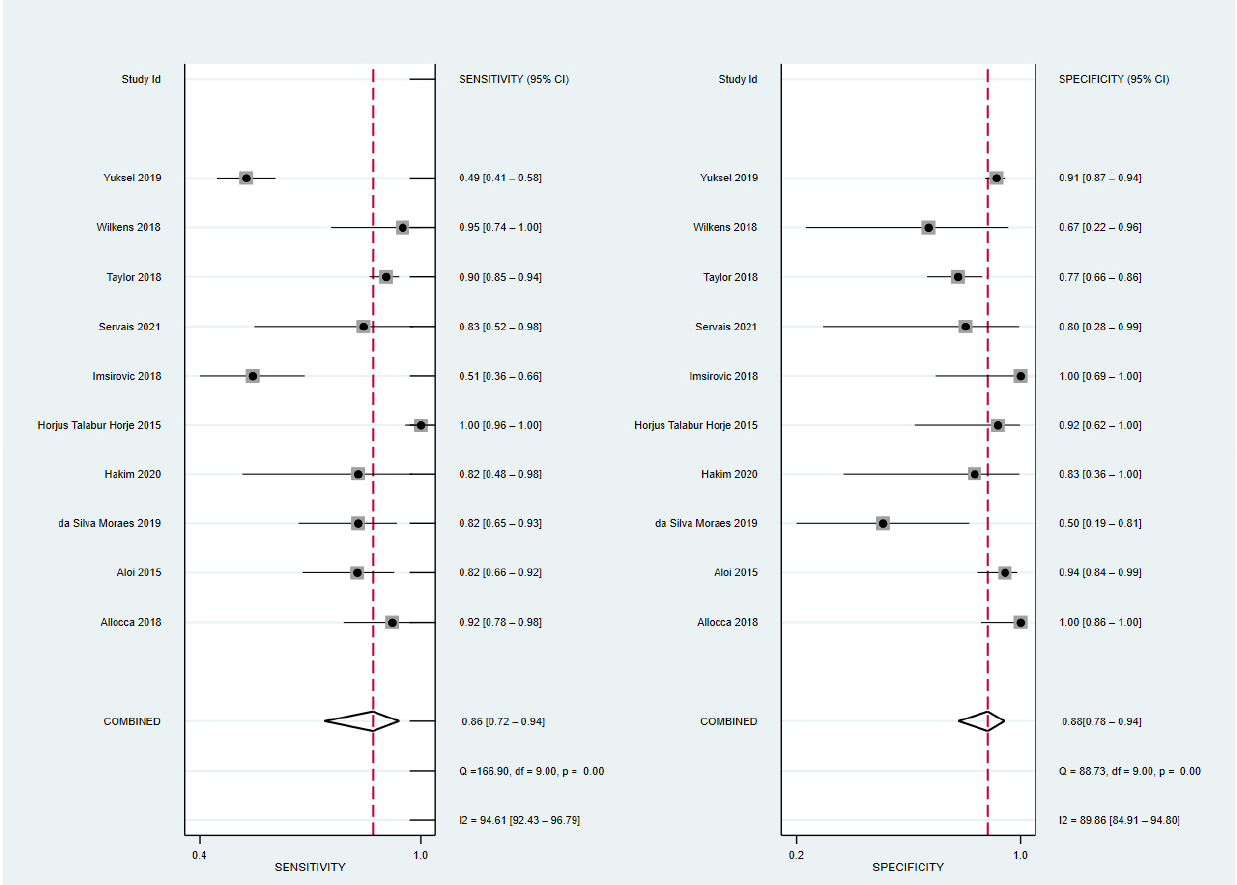
Figure 3. Coupled forest plots of overall pooled sensitivity and specificity for diagnosing active